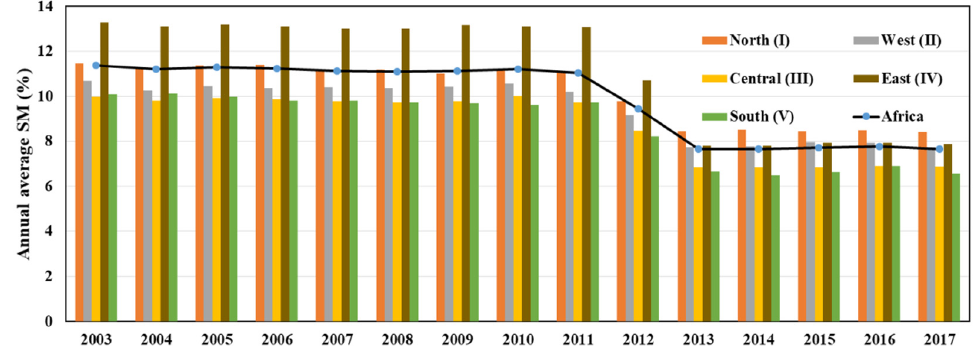
2003 to Figure 5. Interannual variations in the annual average soil moisture (SM) in African subregions from 2003 to 2017.